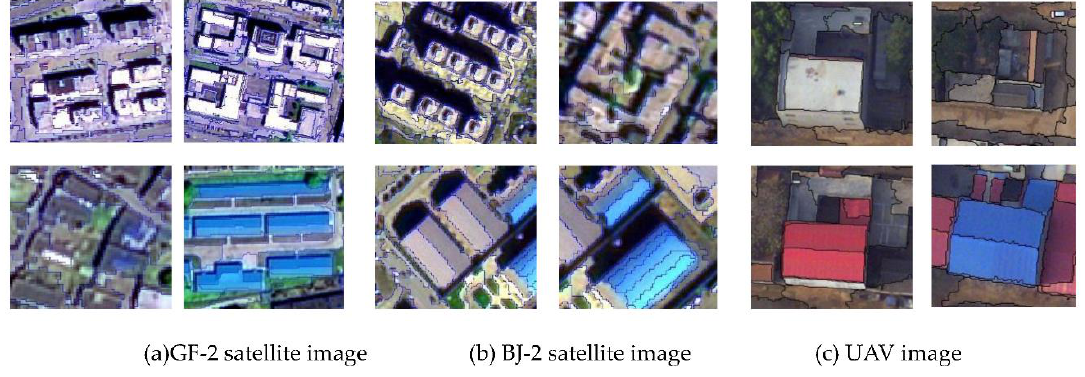
Figure 6. Schematic of training and test samples.